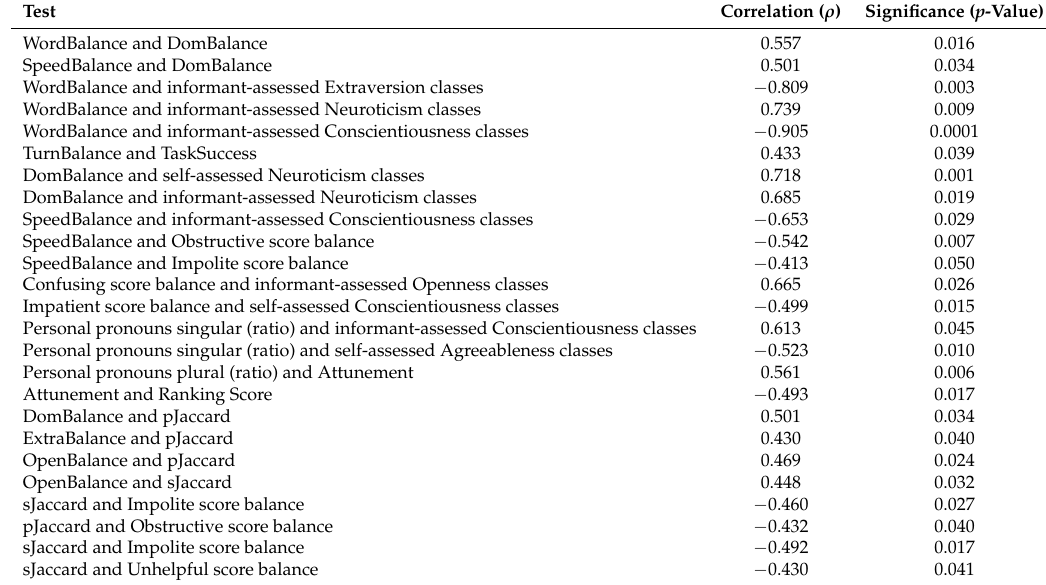
Table 3. Significant correlations among measures of collaboration. The first column includes the measures tested, the second column reports the Spearman’s rank correlation coefficient ( ρ ) value and the third column the p